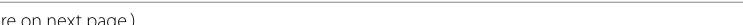
figure on next Fig. 2 Cardiac effect of hypertonic sodium and calcium salt during hyperkalemia. During hyperkalemia, resting membrane potential increases, derecruiting the sodium voltage gate channel Nav1.5 (left panel). Calcium salts bind to calcium-dependent calmodulin and protein kinase II (CaMKII) and activates the sodium voltage gate channel leading to an intracellular sodium entrance (right panel). Calcium salt restores the channel activity though the calcium-dependent calmodulin (CaM), recruiting the voltage-gated channel Nav1.5, increasing the intracellular sodium entrance, restore dV/dt phase 0 action potential and increase in the resting membrane potential. Hypertonic sodium increases extracellular sodium concentration and “forces” intracellular sodium entrance (right panel). The bottom panel represents on the left the decrease of dV/dt phase 0 action potential due to hyperkalemia (Bottom left panel), restored by either calcium or hypertonic sodium (Bottom rightpanel)(Adapted from [40, 41] with